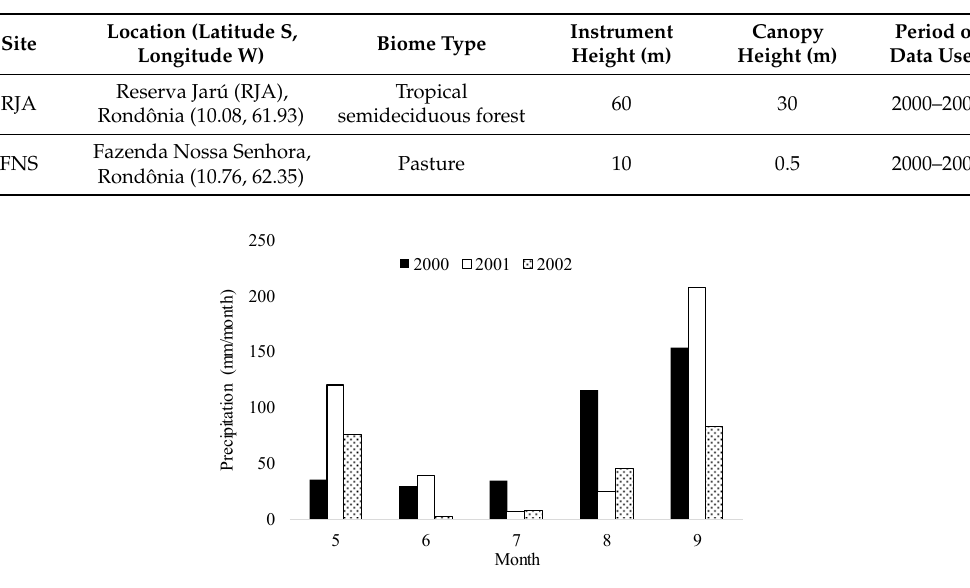
Figure 2. Monthly average precipitation over the dry season at RJA in Rondônia.